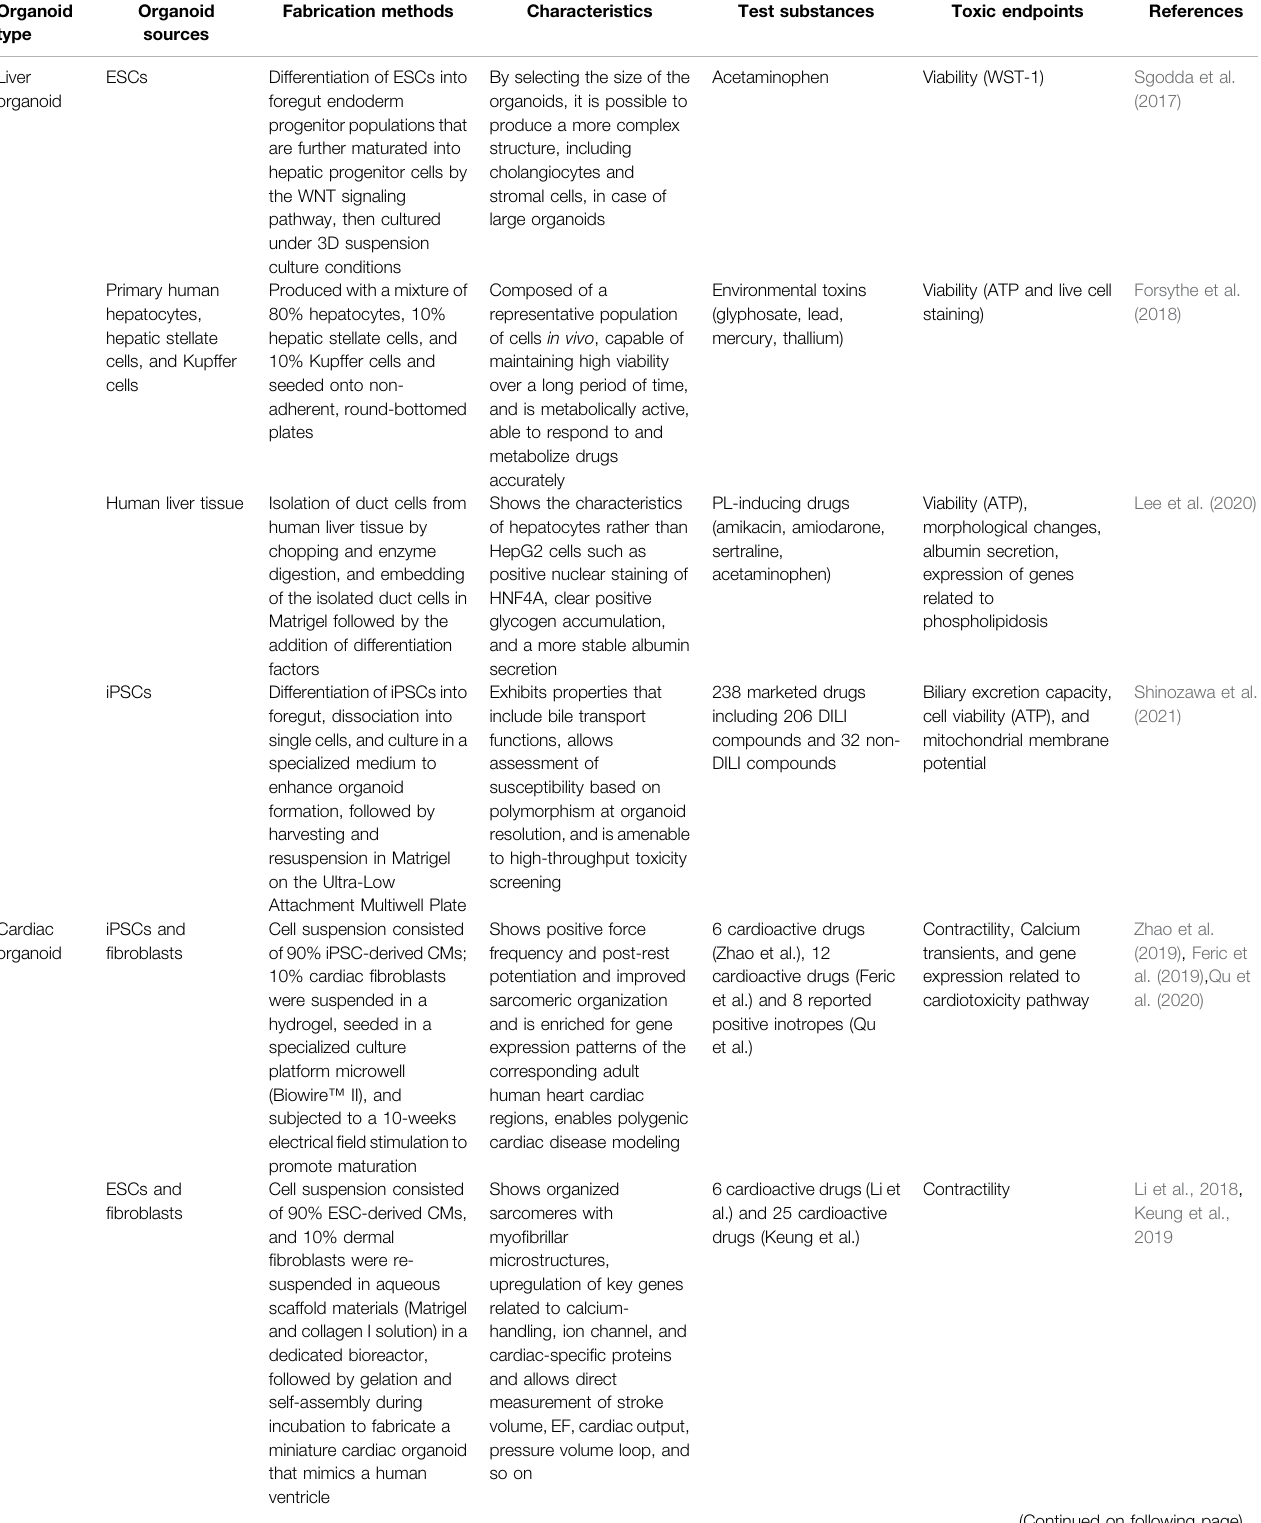
TABLE 1 | Organoid-based toxicity